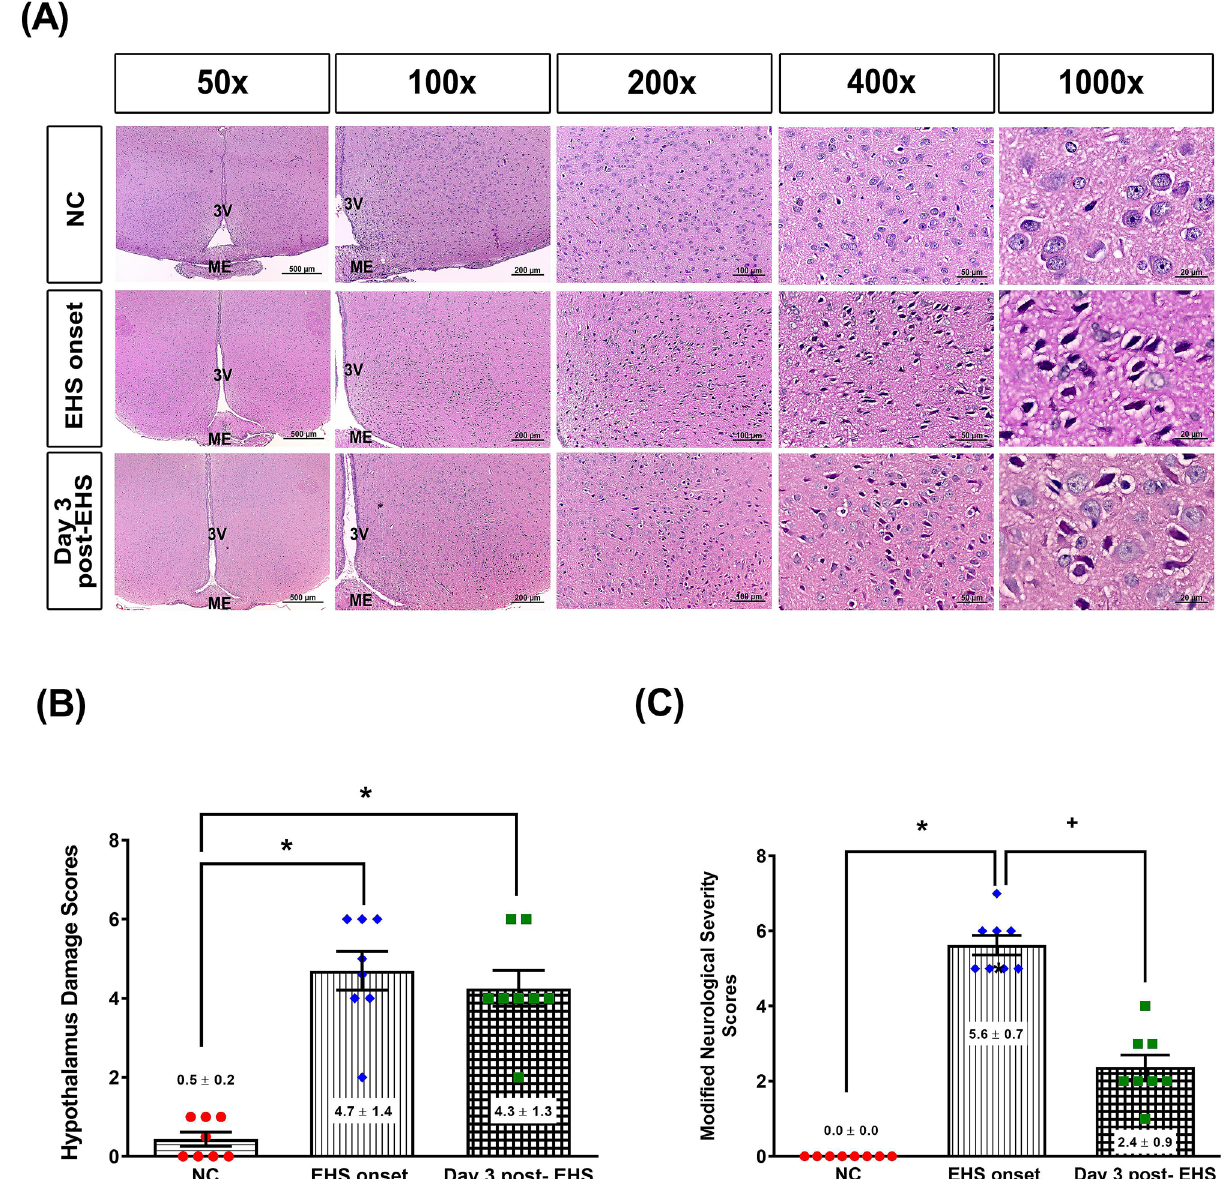
Figure 2. Histological alterations and quantitative analysis of rat hypothalamic tissues and neurological function deficits from the three groups. ( A ) Representative histological images are presented, following hematoxylin and eosin staining of the brain of rats from the NC, EHS onset, and Day 3 post-EHS. Images of brain morphology are shown at ×50, ×100, ×200, ×400 and ×1000 magnification. Scale bars = 500 μm, 200 μm, 100 μm, 50 μm, and 20 μm. ( B ) The quantitative analysis of the histological alterations in the different groups. ( C ) The extents of neurological injury were evaluated by modified neurological severity scores from the three groups. Data are presented as the mean ± standard deviation (n = 8 for each group). The EHS rats displayed many pyknotic cells and vacuolization in their hypothalamic brain tissues. *P < 0.05, EHS onset vs. NC or Day 3 post-EHS vs. NC. + P < 0.05, Day 3 post-EHS vs. EHS onset. 3 V = third ventricle; ME = median